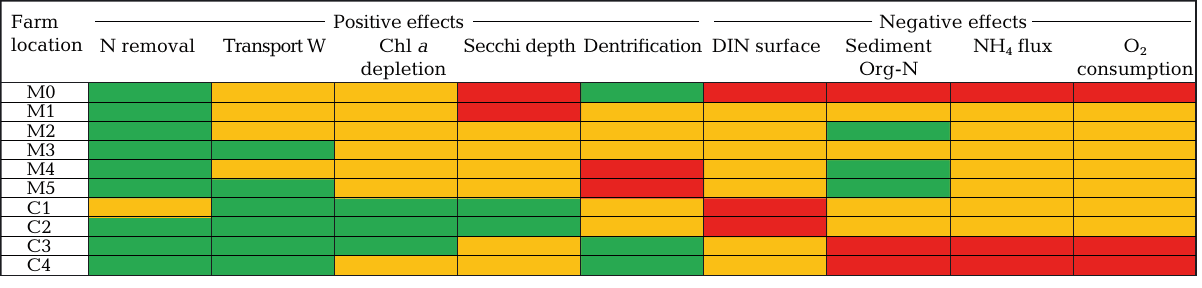
Table 3. Ranking of scenarios (farm location) based on changes in water quality and sediment impacts. Positive effects: N re- moval by harvesting, reduced transport to the western EU Water Framework Directive (WFD) area, reduced chl a concentra- tion, higher Secchi depth and higher denitrification. Negative effects: higher surface dissolved inorganic nitrogen (DIN) concen- trations, higher sediment organic N content, higher NH 4 flux from sediment and higher sediment oxygen consumption. ‘Green’